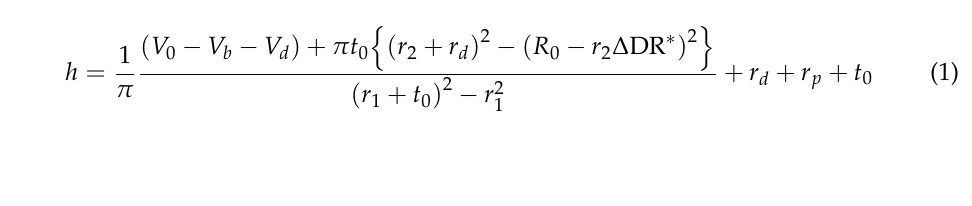
( b ) Figure 9. Effects of BHF and SPD on the fracture limit obtained in the warm superplastic deep drawing experiment (DR = 3.1). ( a ) Fracture limit BHF, ( b ) fracture limit SPD. 3.3. Theoretical Fracture Limit and Wrinkle Limit of Warm Deep Drawing for Middle Size Blank As described in Section 3.1, for DR = 5 with considerably large blank in a superplastic warm deep drawing, it is clarified that it is particularly difficult to obtain a successful drawn product with a uniform thickness, which also affects the wrinkling behavior. Thus, here the authors show the theoretical results of warm deep drawing using a blank with a smaller diameter, which makes it easier to obtain a more uniform thickness distribution. Figure 10 shows the wrinkle limit BHF and fracture limit BHF for the warm superplastic deep drawing process with DR = 2.5 at different SPDs calculated from the simplified theory above. Compared to the previous studies by the authors who reported on SPCE steel sheet ( m = 0.018) [27] and aluminum alloy A5182-O ( m = 0.11, 300 °C) [23], the wrinkle limit and fracture limit BHFs curves for the superplastic material with a larger m value (0.32) are expected to be different.